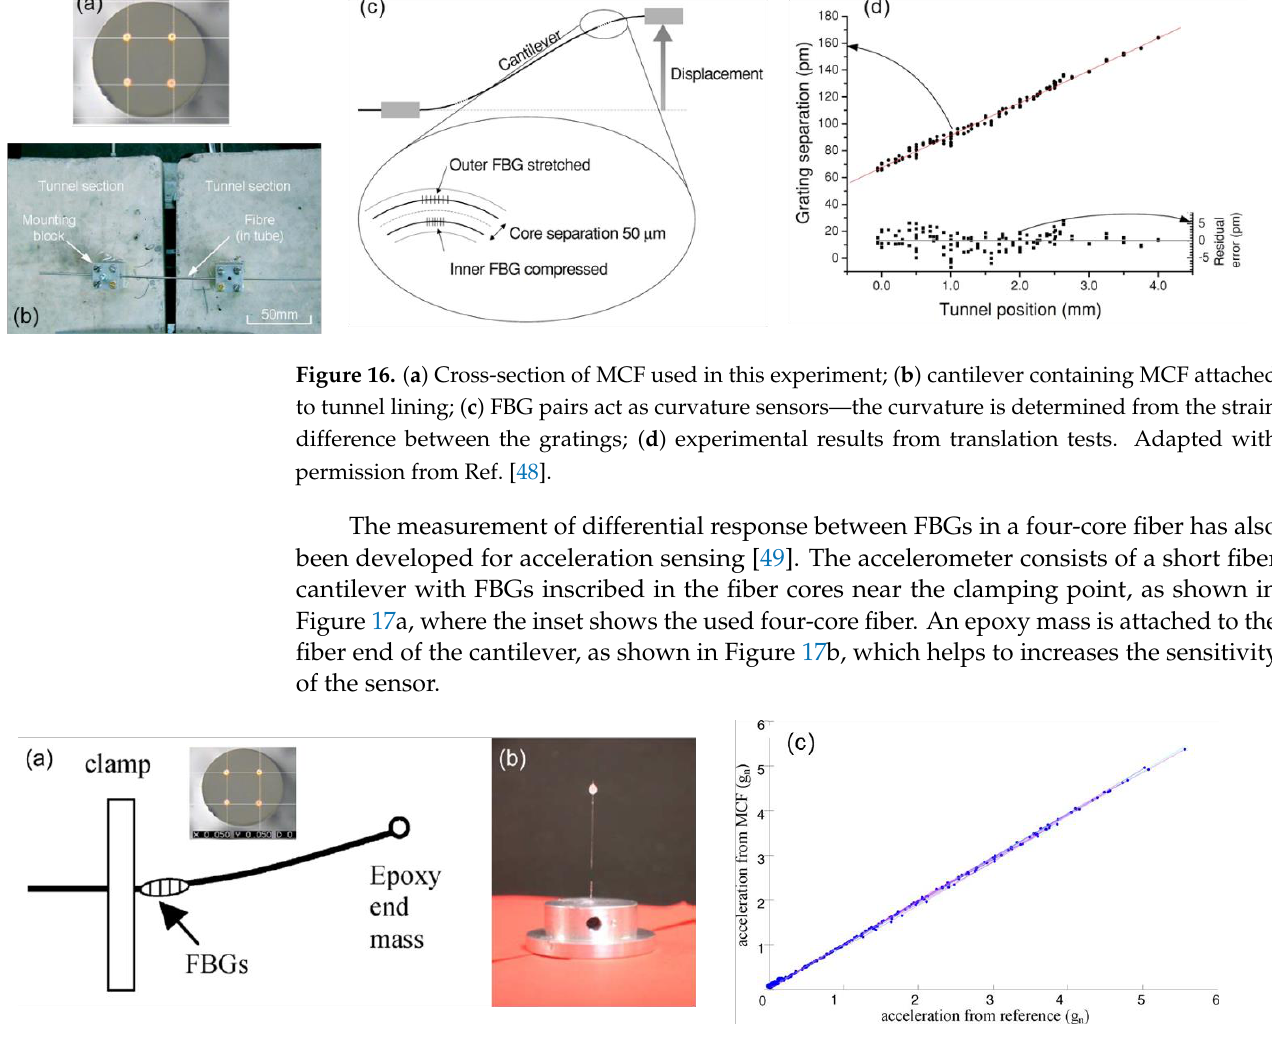
Figure 17. ( a ) Schematic diagram of the MCF cantilever-based accelerometer, the inset shows the four-core fiber used in the experiment; ( b ) the packaged acceleration sensor; ( c ) acceleration response of MCF accelerometer between 30 and 200 Hz. Adapted with permission from Ref. [49].